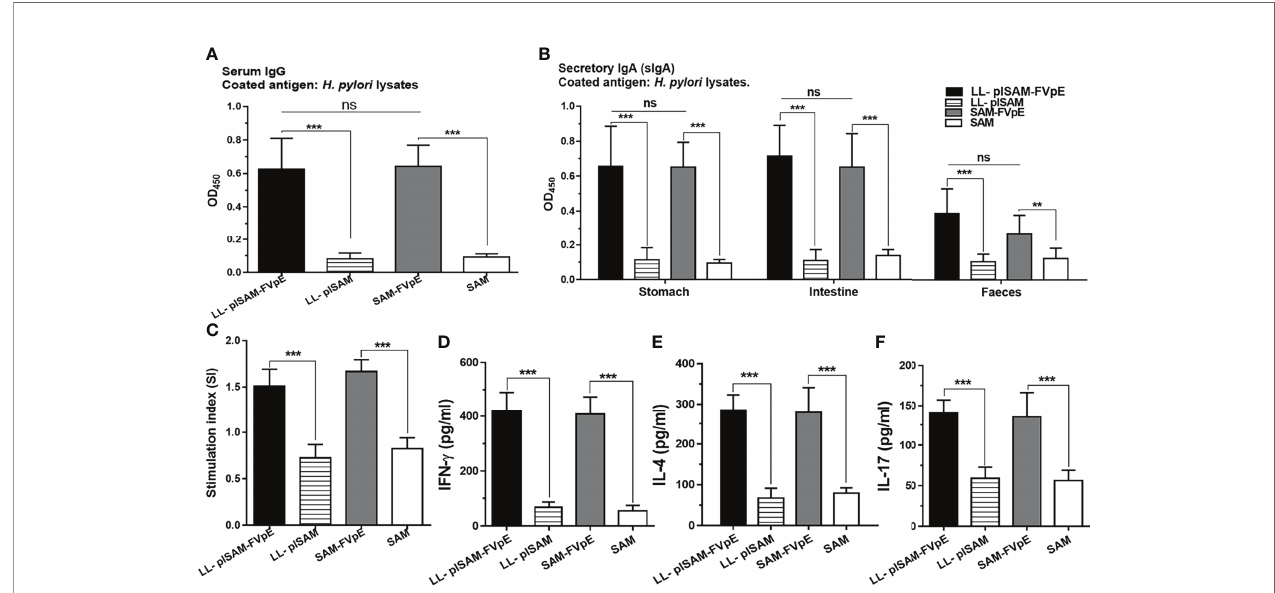
FIGURE 6 | ( H ) pylori -speci fi c lymphocyte and antibody responses after prophylactic immunization. (A, B) Serum IgG and mucosal sIgA against ( H ) pylori . The sera, stomach, intestine and feces were collected. The sera (1:1000 diluted), stomachs and intestine samples (diluted 1:5 in PBS) were tested for ( H ) pylori -speci fi c antibodies by ELISA. ***: p <0.001, ns not signi fi cant. (C) Proliferation of ( H ) pylori -speci fi c lymphocytes. Lymphocytes were isolated from mice immunized with LL- plSAM-FVpE, SAM-FVpE plus PA, LL-plSAM or SAM plus PA, and cultured with ( H ) pylori lysates (5 m g/ml) for 72 h. Lymphocyte proliferation was determined. ***: p <0.001. (D – F) Detection of the cytokines. After stimulation with ( H ) pylori lysates, cytokines (IFN- g , IL-4 and IL-17) were detected by ELISA. ***: p